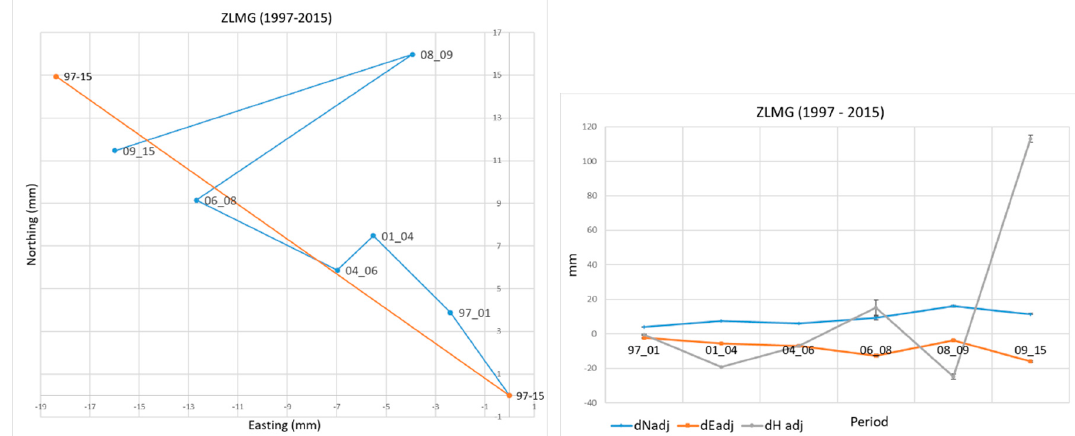
Figure 13. Point ZLMG. Example of prevailing of the same direction towards WNW and WSW, only